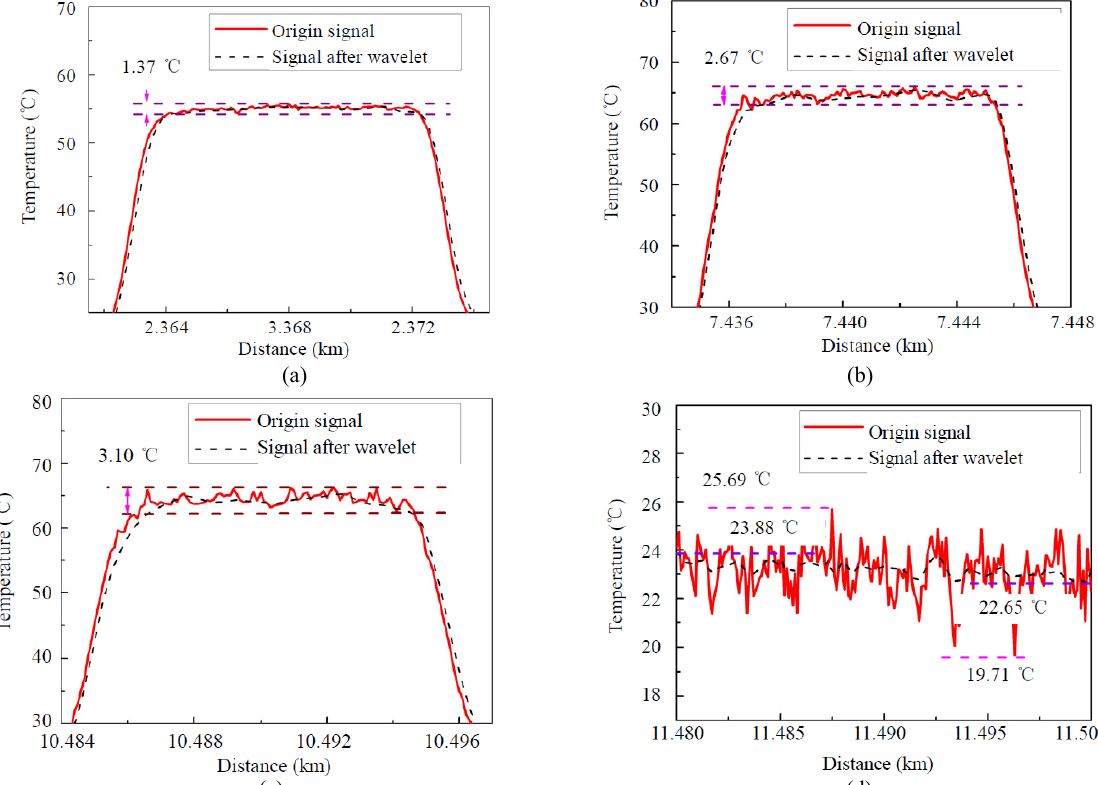
Fig. 7 Results demodulated by origin signal and the signal after wavelet at different sensing distances at: (a) Test 1, (b) Test 2, (c) Test 3, and (d) the end of the test fiber under room